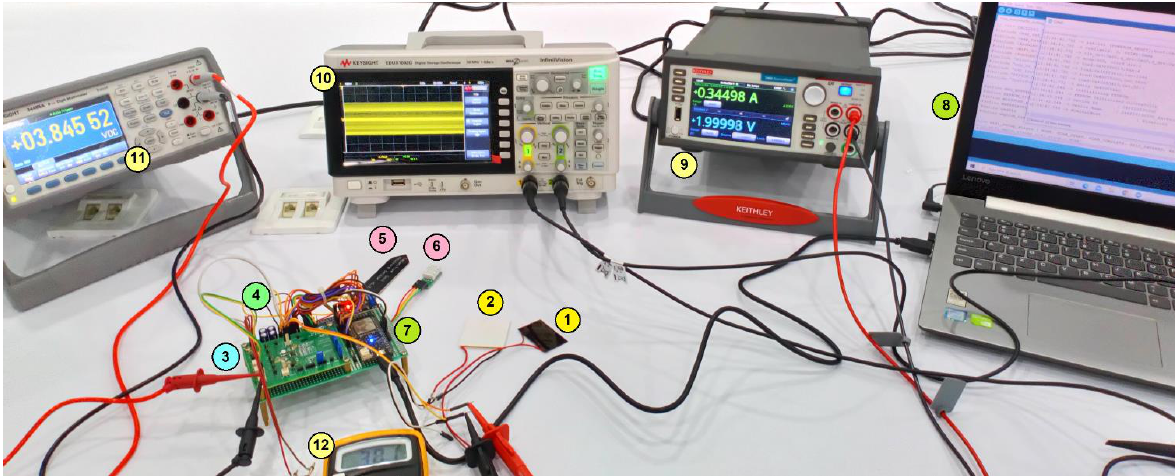
Figure 9. Experimental test bench: (1) AM-1454 solar PV module; (2) GM250-71-14-16 TEG module; (3) ADP5091 EH mod- ule; (4) Supercapacitor (0.47 F, 5.5 V); (5) SEN0193 V1.2 capacitive soil moisture sensor; (6) SHTC3 temperature and hu- midity sensor; (7) ESP32 Wi-Fi module; (8) IoT connection through serial monitor; (9) input voltage; (10) Oscilloscope view of input voltage; (11) charging voltage; (12) SC voltage.